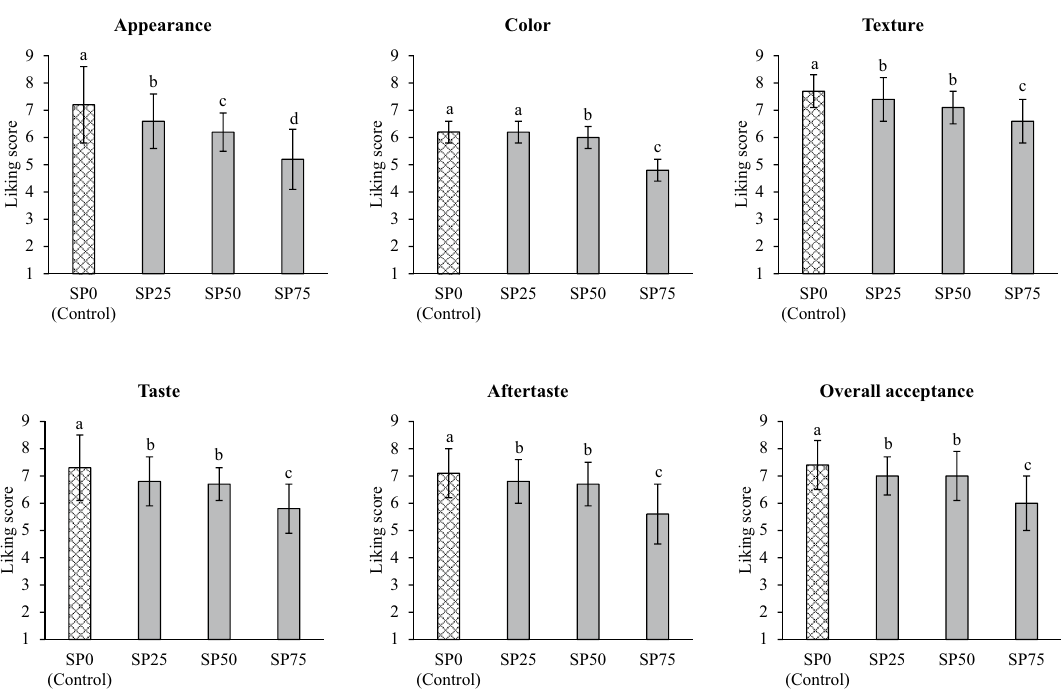
Figure 4. Sensory characteristics (liking score) of silkworm pupae-fortified chicken bread spread at different levels. SP0 (Control): Chicken bread spread without fortification with silkworm pupae. SP25, SP50, and SP75: Silkworm pupae-fortified chicken bread spread with the replacement of chicken meat at 25, 50, and 75%, respectively. Different letters on the bars indicate significant differences ( p ≤